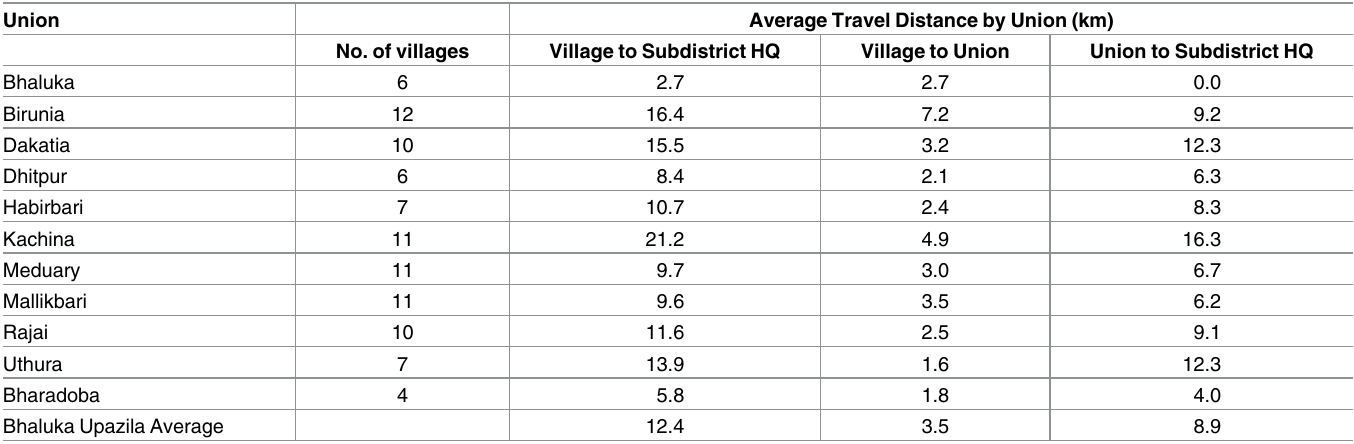
Table 2. Travel distances in Bhaluka subdistrict.